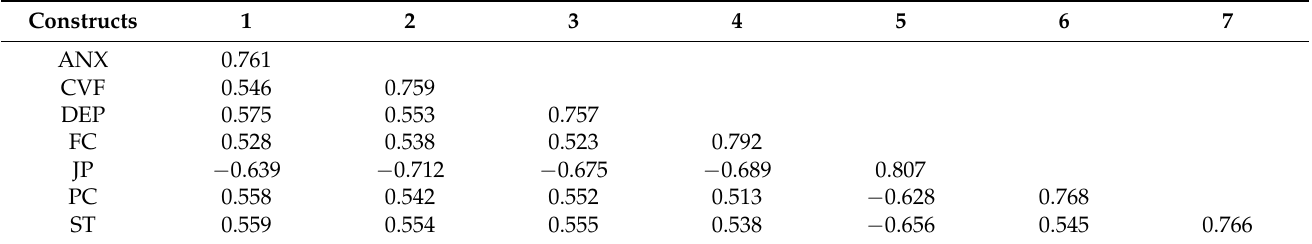
Table 4. Discriminant Validity Analysis (Fornel–Larcker).